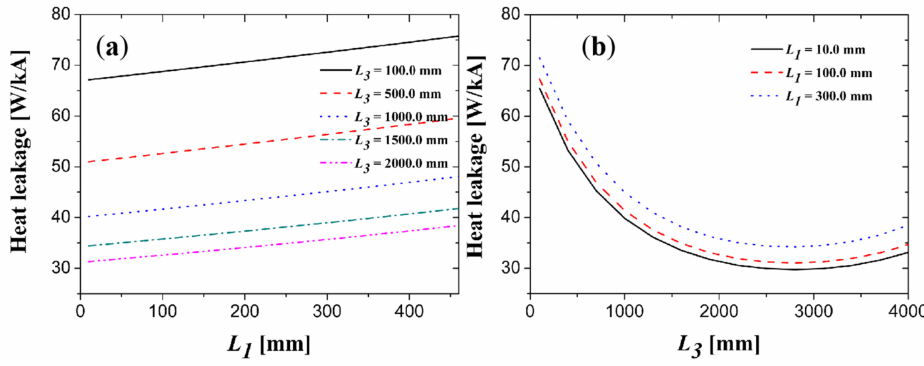
Figure A14. Iteration step two: the coupling influence between B ( L 1 ) and C ( L 3 ) on the cold end heat leakage of PCLs (keeping parameters r 1 = 20.0 mm, r 2 = 30.0 mm, L 2 = 7.5 mm unchanged; in this iteration Q min = 29.8 W/kA). ( a ) The heat leakage vary with B ( L 1 ); ( b )The heat leakage vary with C ( L 3 ).